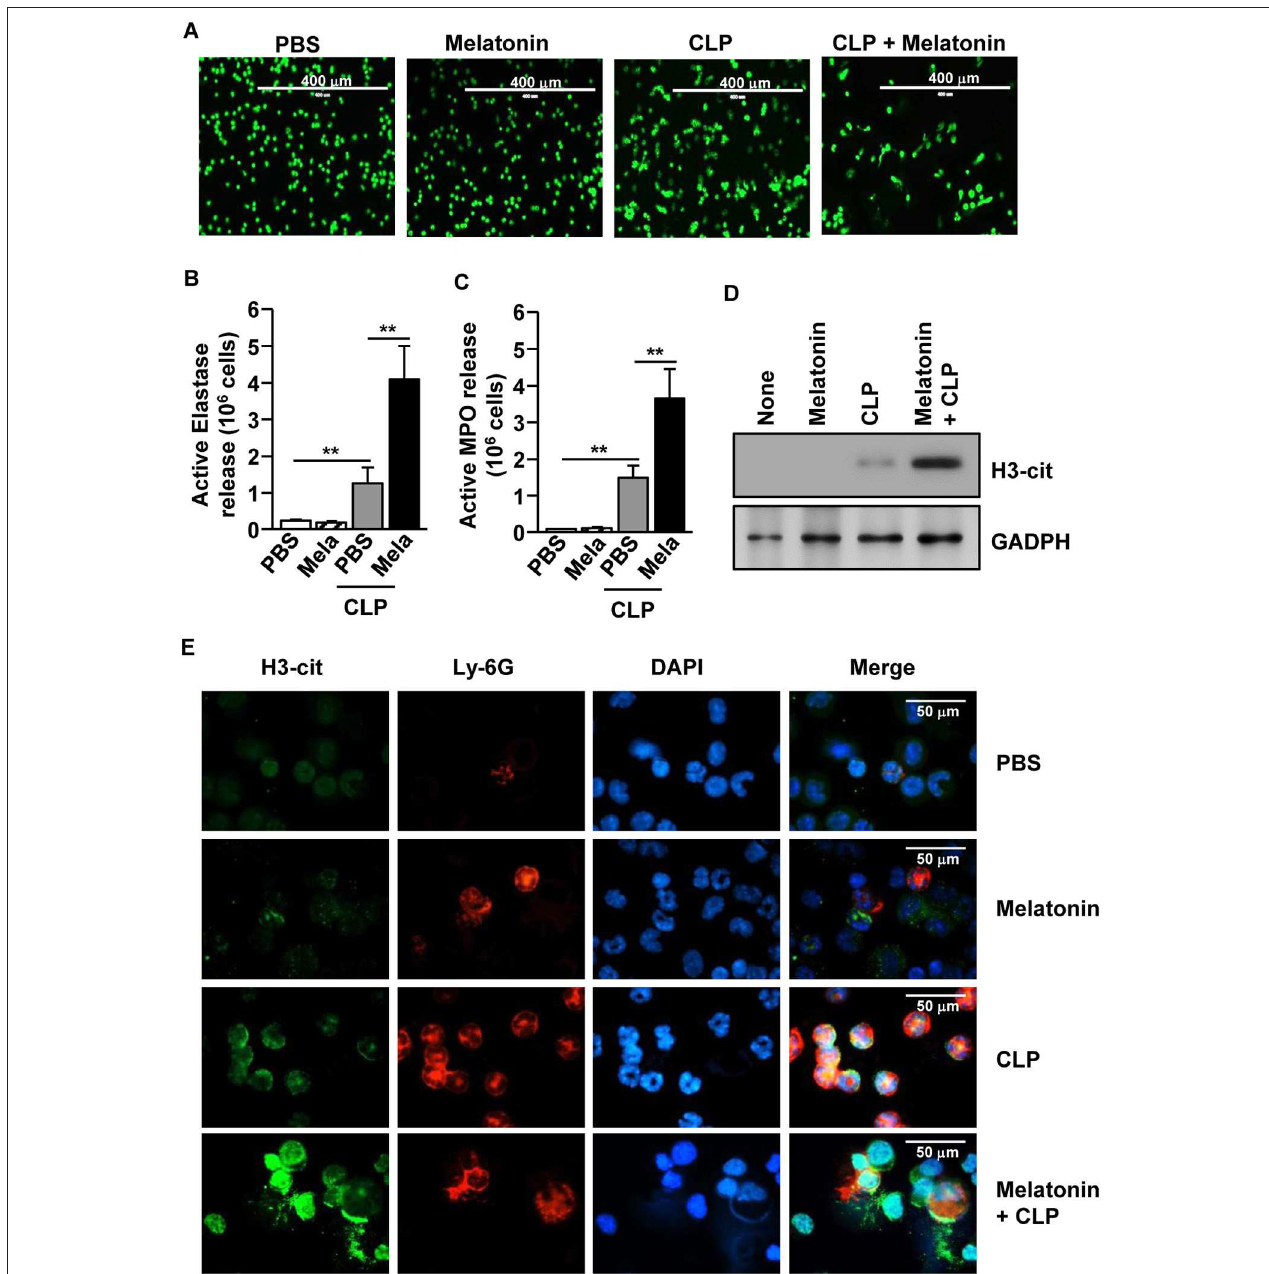
FIGURE 5 | Melatonin-induced neutrophil extracellular traps (NETs) in polymicrobial infection. C57BL/6 Mice were treated with 50 mg/kg melatonin and then subjected to CLP surgery. The mice were further injected with 50 mg/kg melatonin 30min after the CLP surgery. (A) Peritoneal neutrophils were harvested and stained with SYTOX Green, 6h after the CLP surgery. (B) The active elastase and (C) myeloperoxidase (MPO) levels were measured in the peritoneal fluid. (D) Secreted protein levels of cit-H3 were measured in the supernatant of the peritoneal fluid. (E) The peritoneal cells were analyzed by immunofluorescence staining with Ly-6G, H3-cit, and DAPI. All data represent the average of six independent samples (two mice per experiment, for a total of three experiments), * p < 0.01.